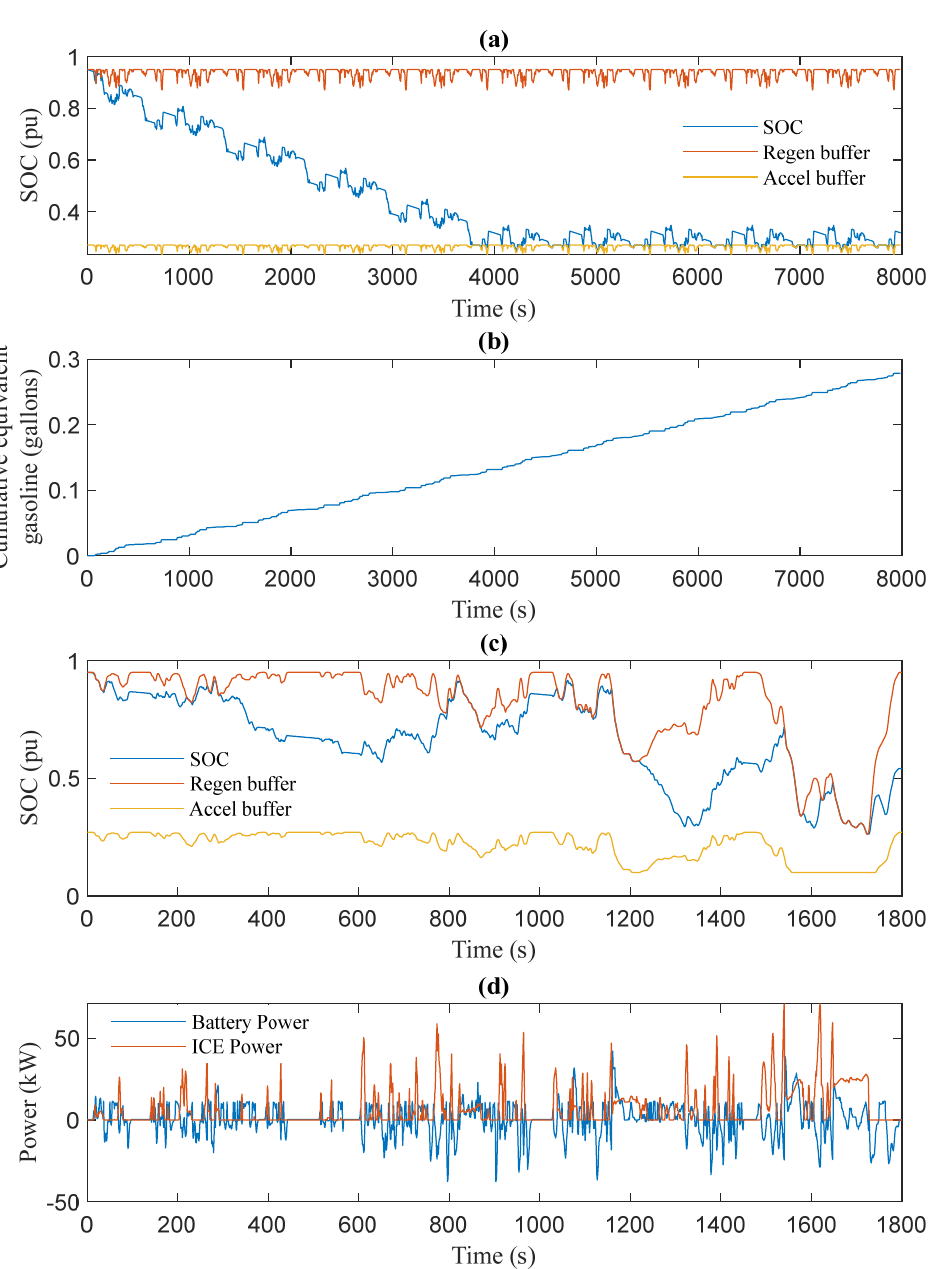
Figure 3. FASTsim simulation results for the HEV of [46]. ( a ) Battery SOC after 10 NYC-HEV cycles; ( b ) cumulative equivalent gasoline consumption in gallons for 10 NYC-HEV cycles; ( c ) battery SOC for one NYC-HEV cycle; ( d ) powers of the battery and the ICE.